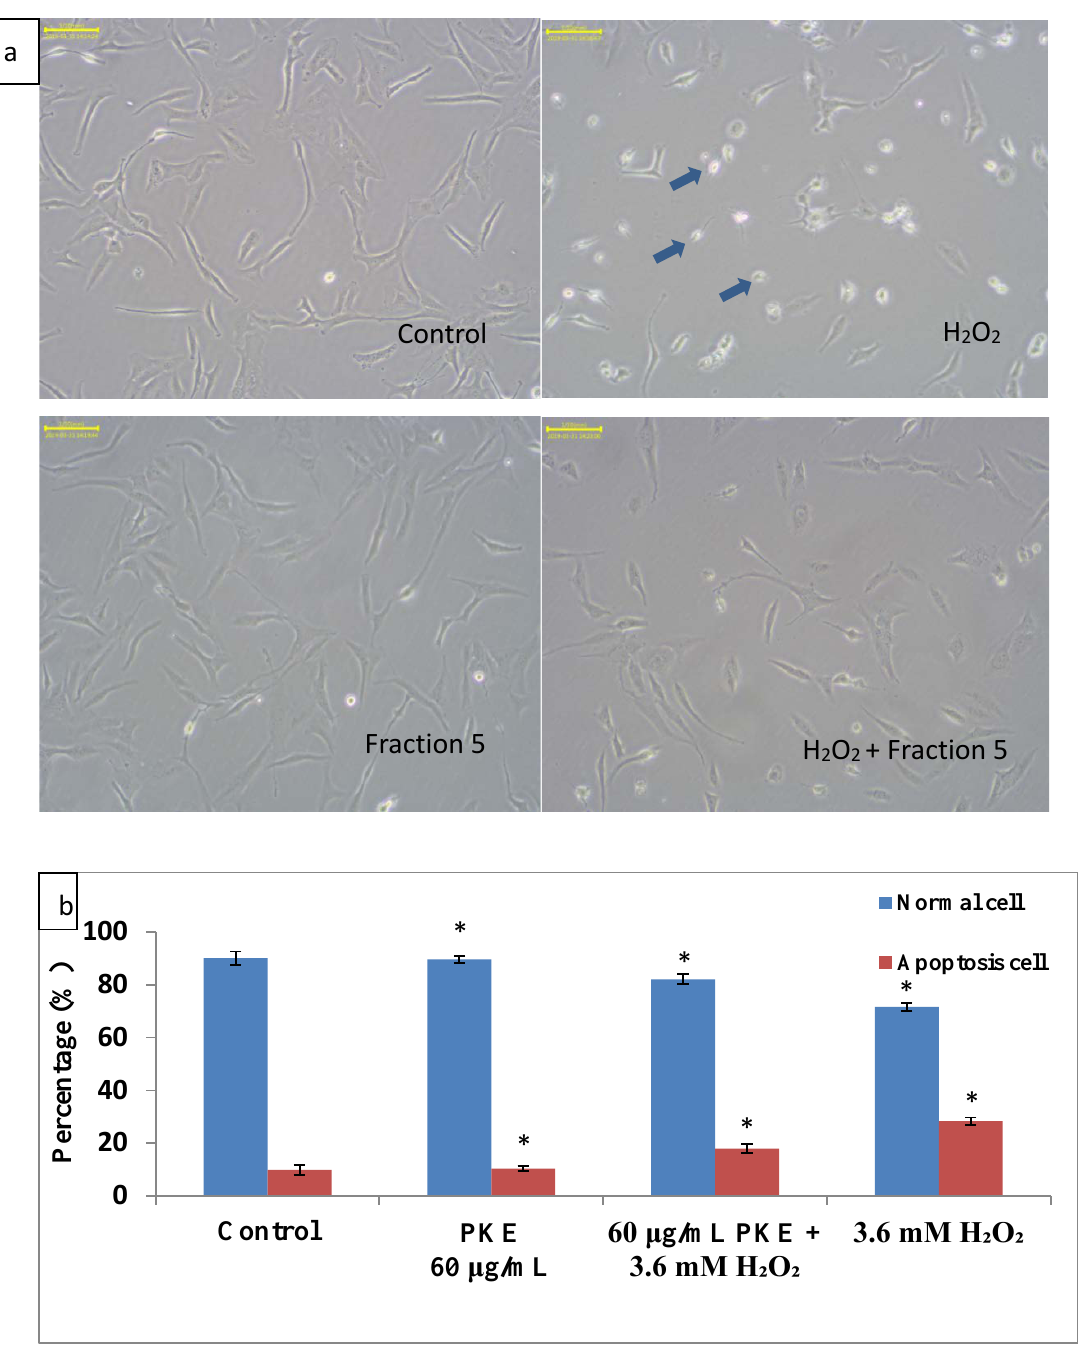
Figure 4. Cellular morphology of SW1353 treated with PKE or H 2 O 2 for 24 h (the arrows are the apoptotic bodies) ( a ); the proportion of apoptotic SW1353 cells treated with PKE extract (60 µ g/mL), PKE (60 µ g/mL) with 3.6 mM added H 2 O 2 , and 3.6 mM H 2 O 2 for 24 h ( b ). scale bar = 100 µ m. Values are expressed as mean ± SD ( n = 3), * p < 0.05 for compared with control